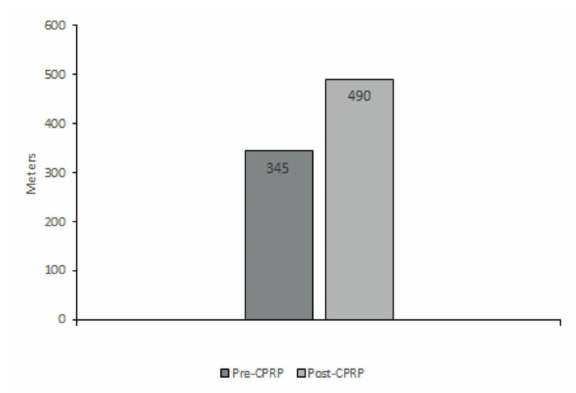
Table 1 - Comparison of vital sign values pre and